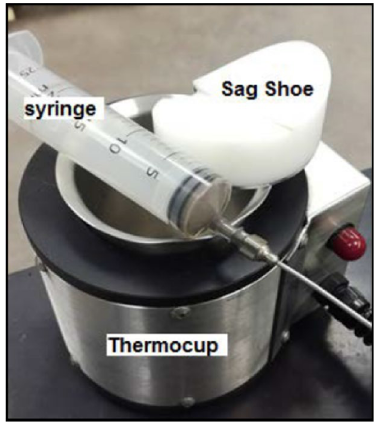
Fig. 2 Apparatus for dynamic sag test (Basfar et al.